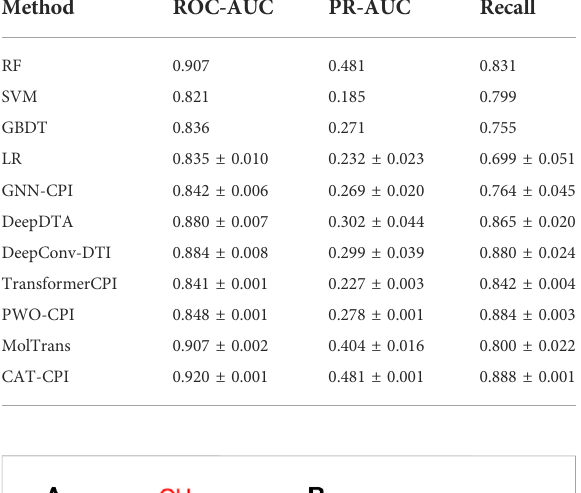
TABLE 3 Comparison with other methods on Davis dataset.